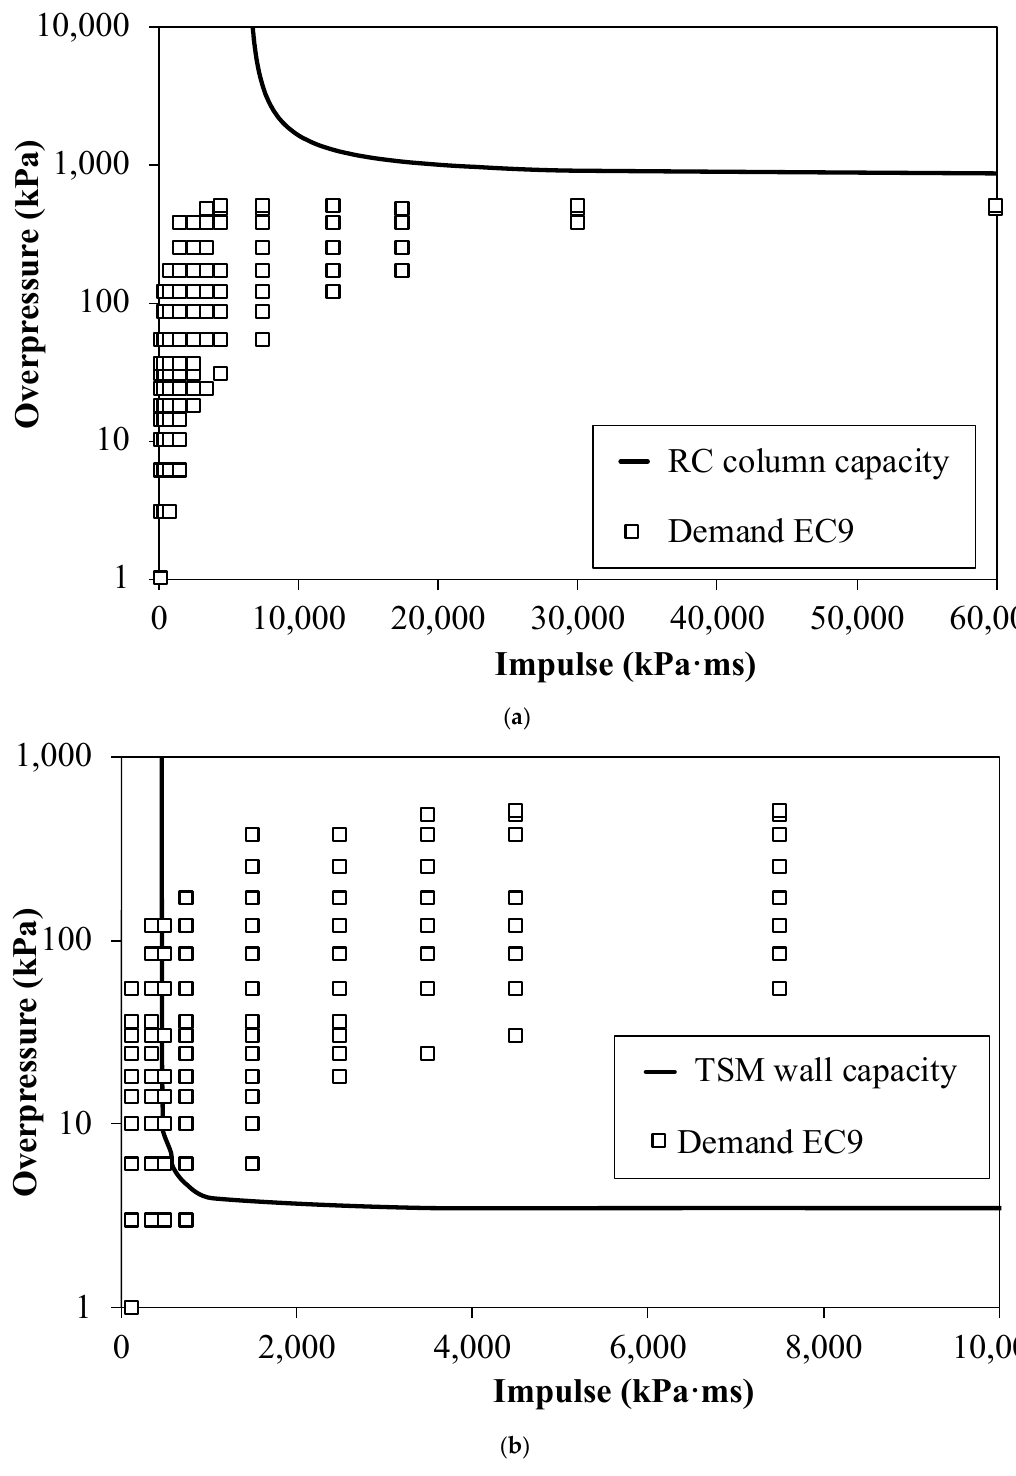
Figure 1. Blast demand and capacity of ( a ) reinforced concrete (RC) columns and ( b ) tuff stone masonry (TSM) walls for explosive class 9 and atmospheric stability class F2.